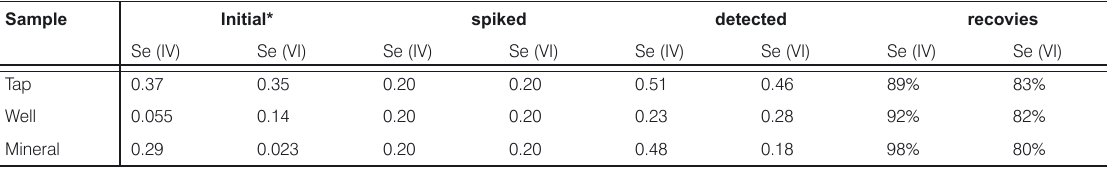
Table 2. Recoveries of selenium species in spiked water samples (ng mL -1 ).